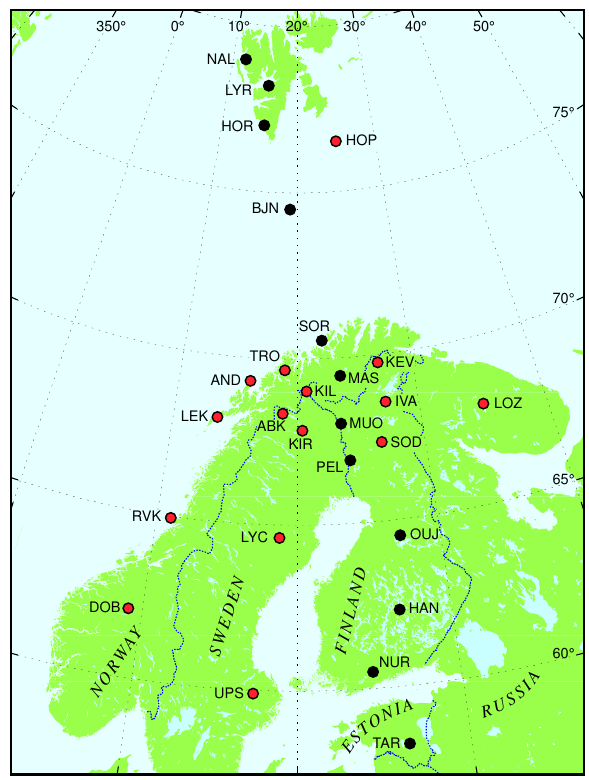
Fig. 1. IMAGE magnetometer network in 2002. Stations marked with black dots are used in the 1-D upward continuation.